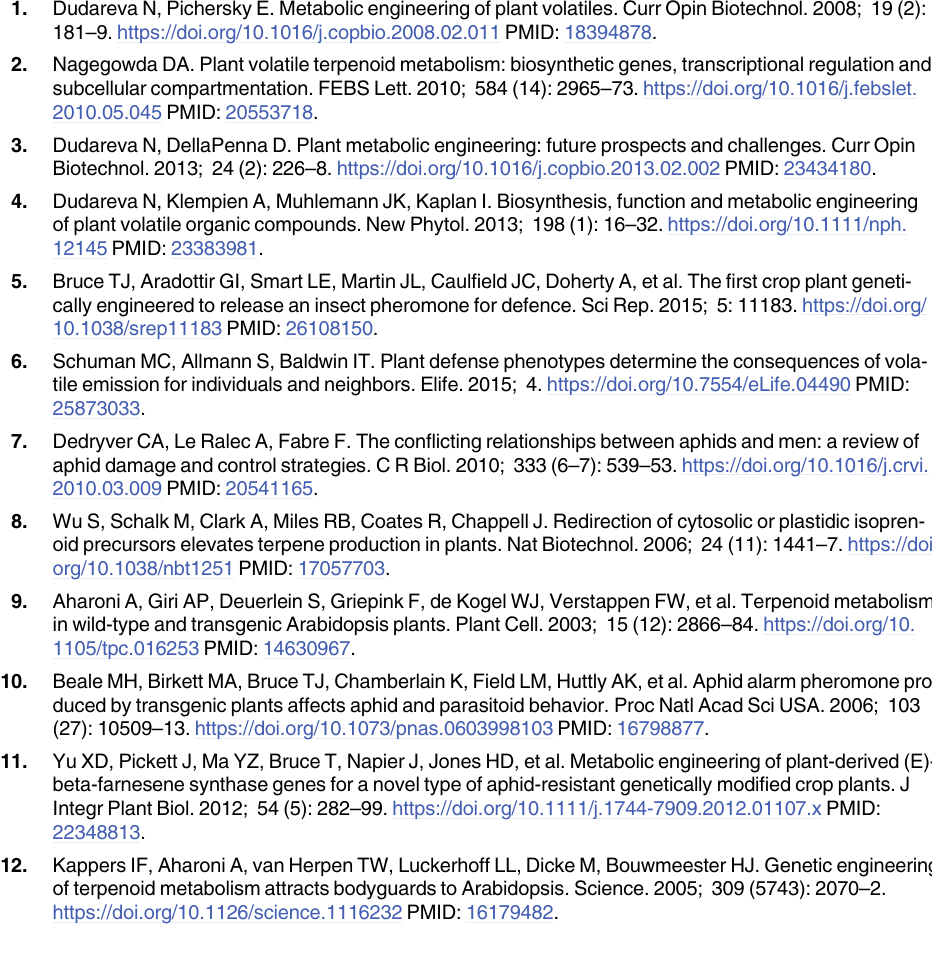
S6 Fig. Green peach aphids two-choice experiments on agar medium plates using santalene and bergamotene solutions: Scale bar = 1 cm.